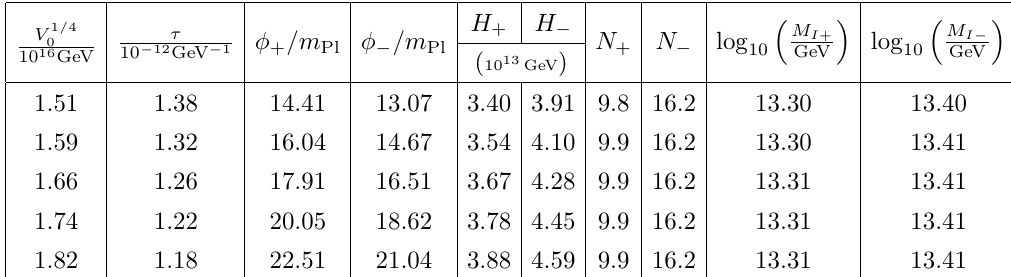
Table 7. Values of the various parameters (indicated by a subscript + ) corresponding to the MACRO bound on the flux of monopoles formed at the scale M subscript − ) corresponding to the adopted observability threshold for the monopole